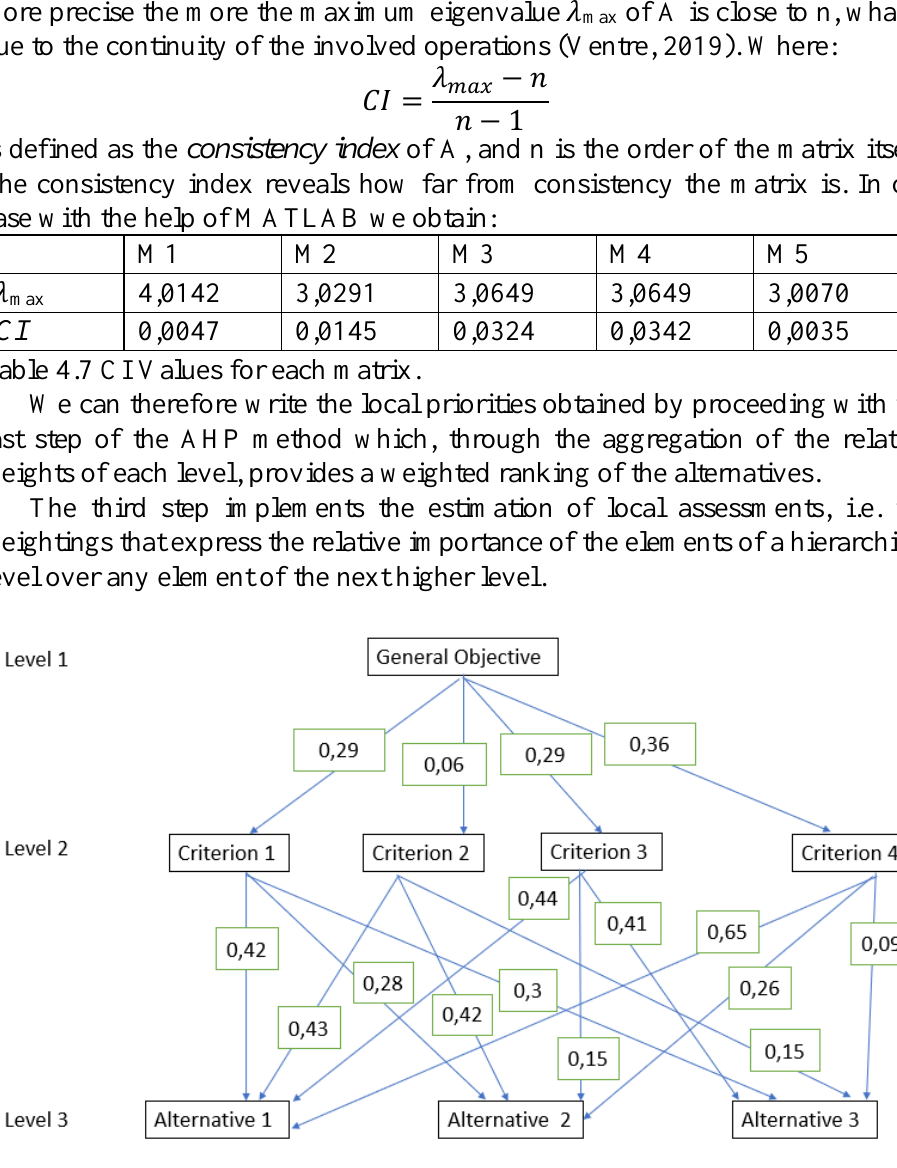
Figure 4.2 The Digraph of the Functional Aspects, with